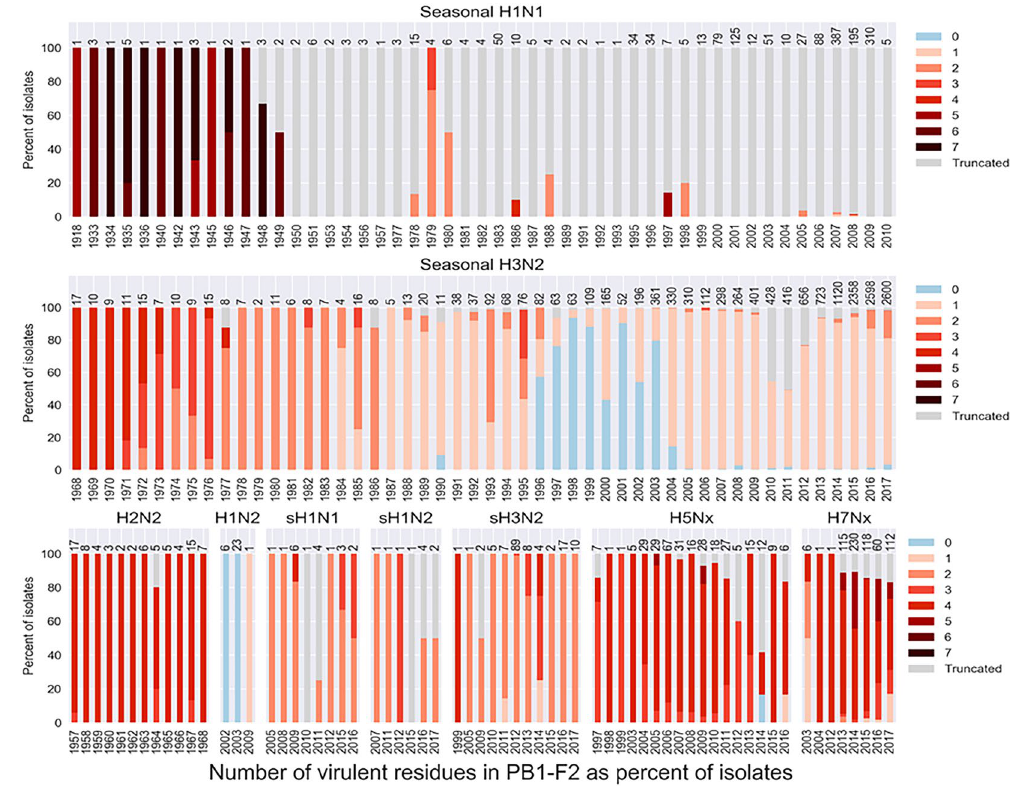
Figure 1. Evolution of PB1-F2 virulence-associated residues in human influenza A viruses. PB1-F2 sequences from human IAV isolates were downloaded from the IRD and GISAID databases on November 25 th , 2017 as described in the text, and the number of virulent residues (L62, I68, L69, V70, R75, R79, and L82) were determined for each subtype per year. Isolates of the H1N1pdm09 not indicated on the graph, since none of them had virulent residues on PB1-F2 due to the presence of premature stop codon at position 12 45 . Swine origin human IAV are indicated as sH1N1, sH1N2, and sH3N2. Avian origin human IAV are indicated as H5Nx and